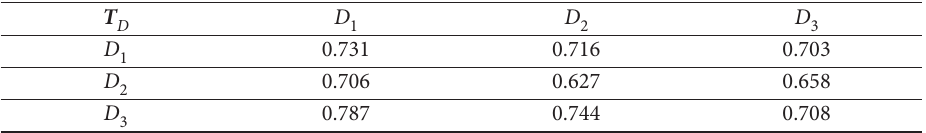
Table 5. The total influence-related matrix T